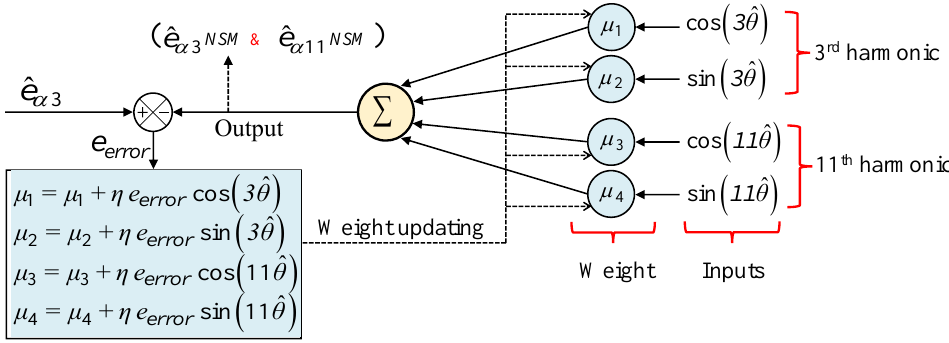
Figure 11. Structure of the ADALINE used by the neural synchronous method [35,36].